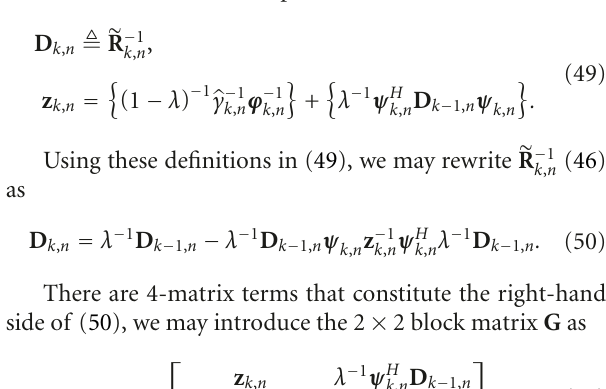
algorithm for computing the PTEQ tap-weight estimate (cid:14) p k , n at symbol k for tone n ∈ N d